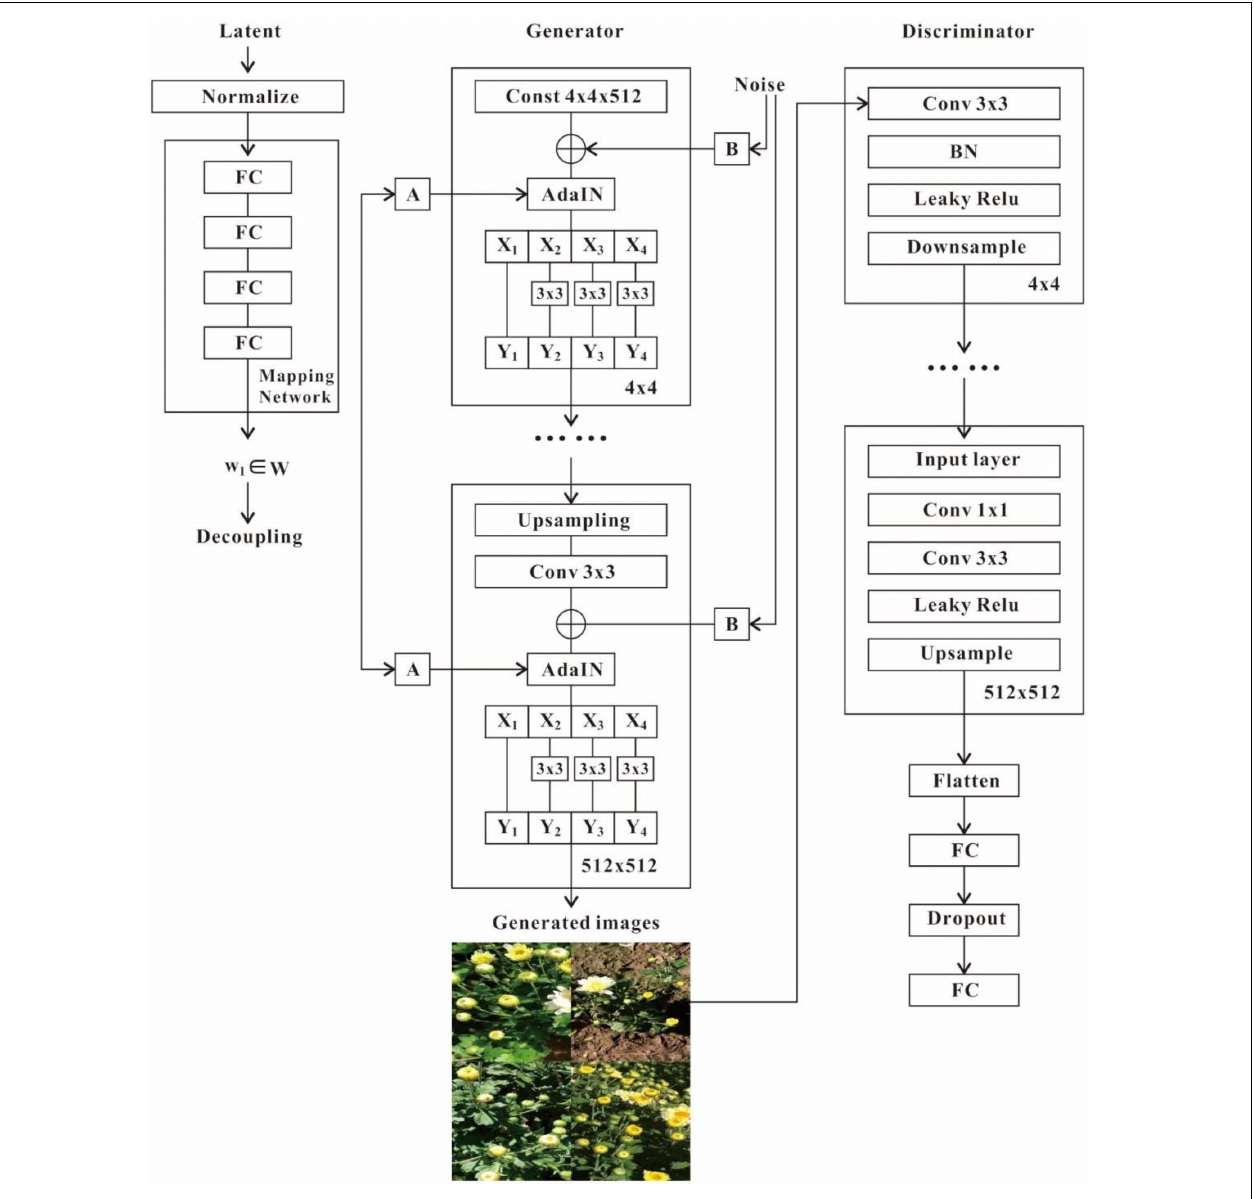
FIGURE 4 | Structure of the proposed TC-GAN network. Mapping network can effectively capture the location of potential codes with rich features, benefiting the generator network to accurately extract complex unstructured features. A represents the learned affine transformation. B denotes the learned per-channel scaling factor applied to the noisy input. Discriminator network is designed to guide the training of the generator network, which is continuously confronted by alternating training between the two networks, ultimately enabling the generator network to better execute the generation